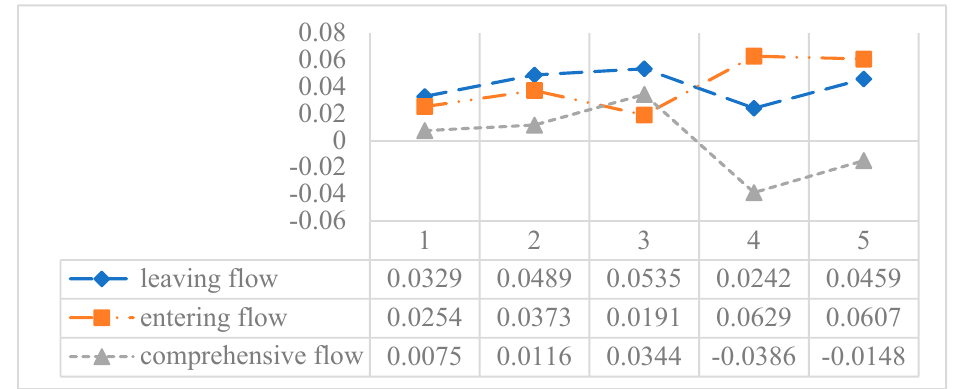
Figure 6. Leaving flow, entering flow and comprehensive flow of hotels in Method 2. Table 13. Ranking results of hotels based on di ff erent